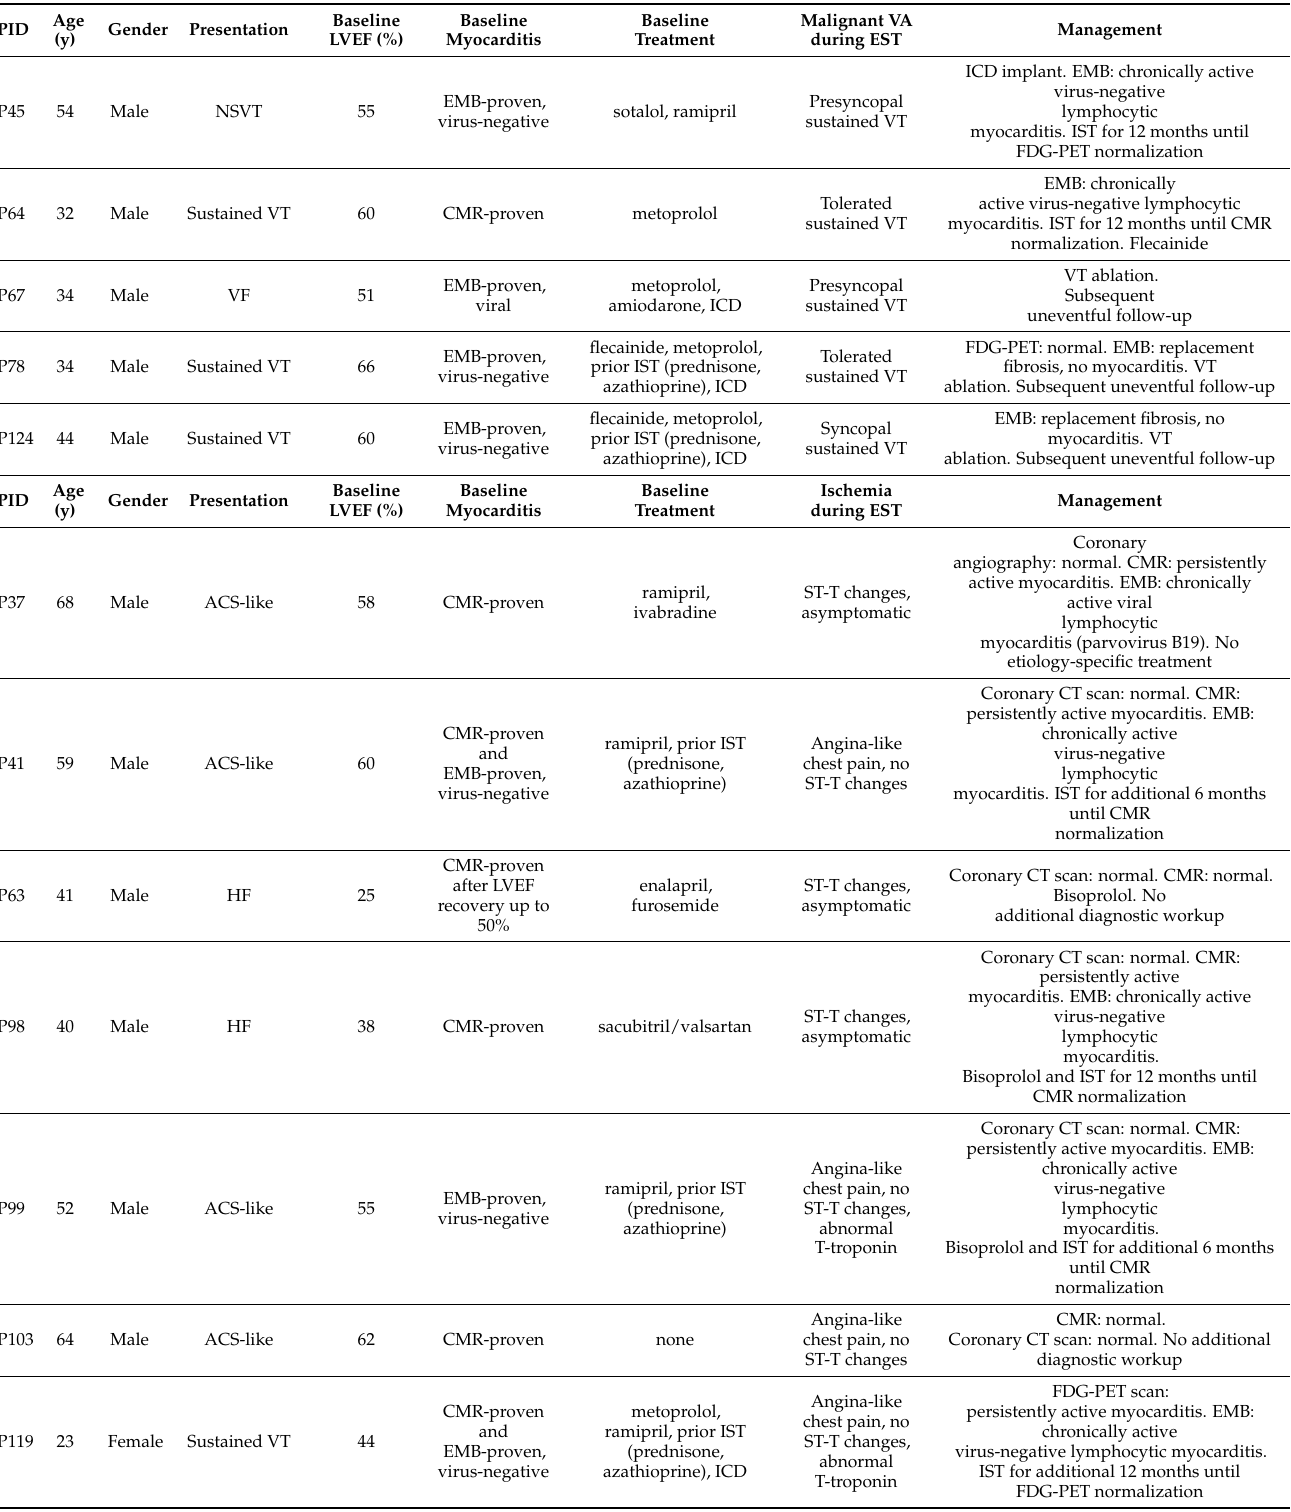
Table 3. Management of patients with ischemia and malignant VA during exercise stress